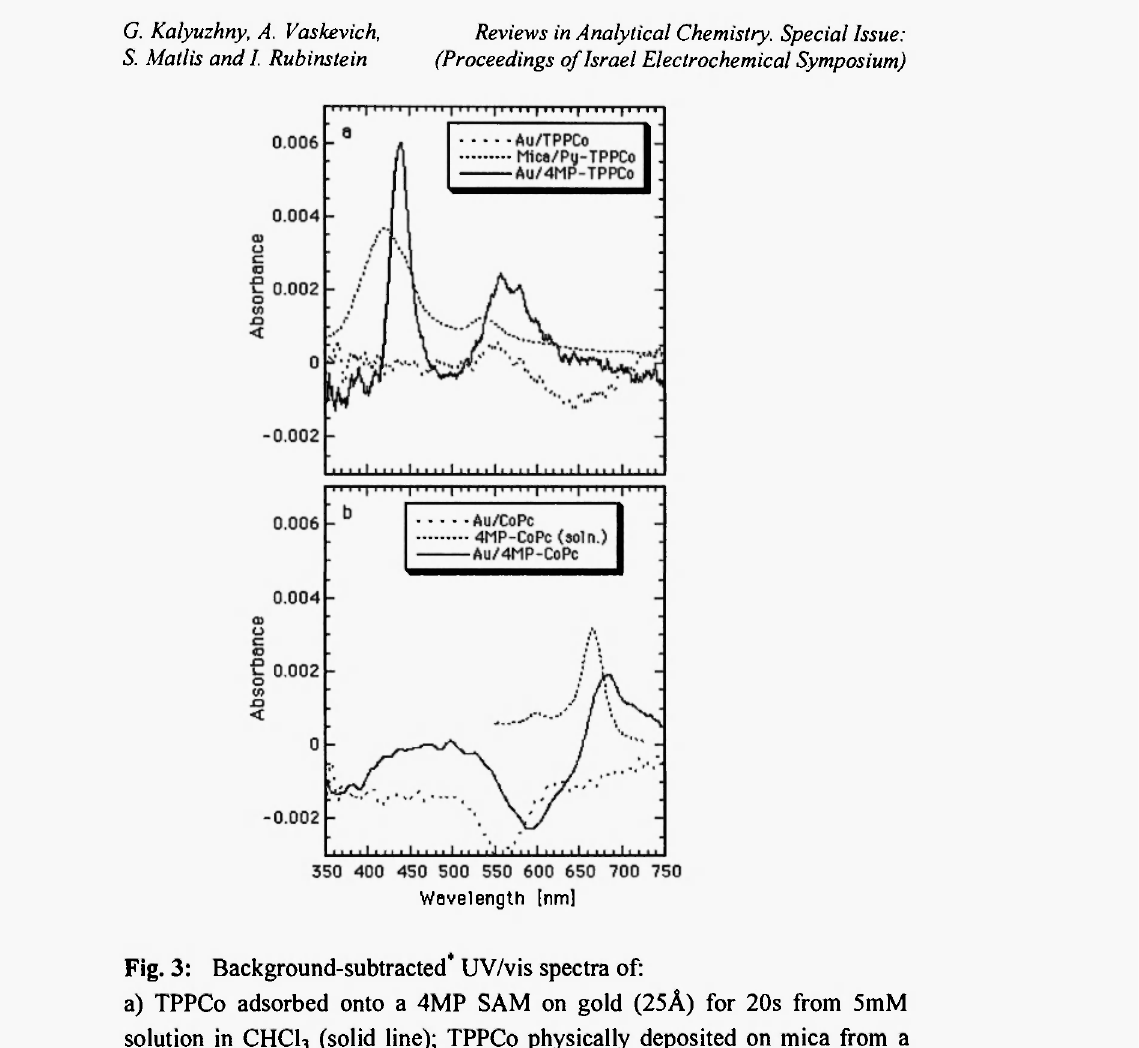
Fig. 3: Background-subtracted* UV/vis spectra of: a) TPPCo adsorbed onto a 4MP SAM on gold (25Ä) for 20s from 5mM solution in CHC1 3 (solid line); TPPCo physically deposited on mica from a pyridine solution (dashed line, the original spectrum was divided by 100); and a gold film immersed into 5mM TPPCo solution in CHC1 3 for 20s (dotted line). b) CoPc adsorbed onto a 4MP SAM on gold (25Ä) for lmin from 0.17mM solution in THF (solid line); a solution of 0.17mM CoPc with a large excess of 4MP (dashed line, the original spectrum was divided by 200); and a gold film immersed into 0.17mM solution of CoPc in THF for lmin (dotted line). 'Spectra obtained prior to the final step in film formation were used for background